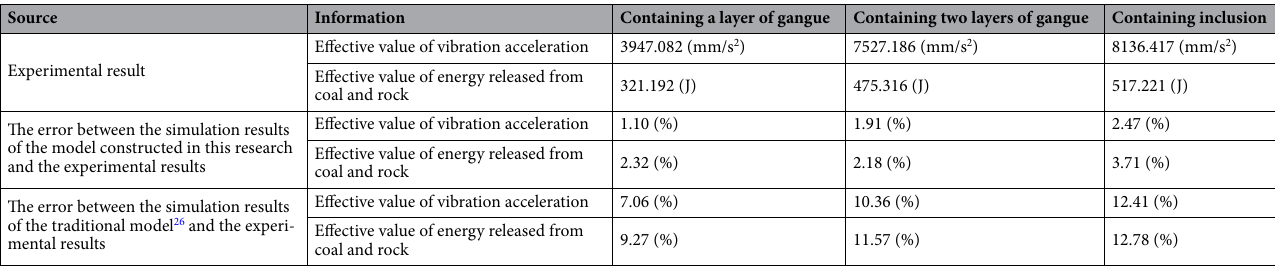
Table 4. Comparison between the experimental and simulation